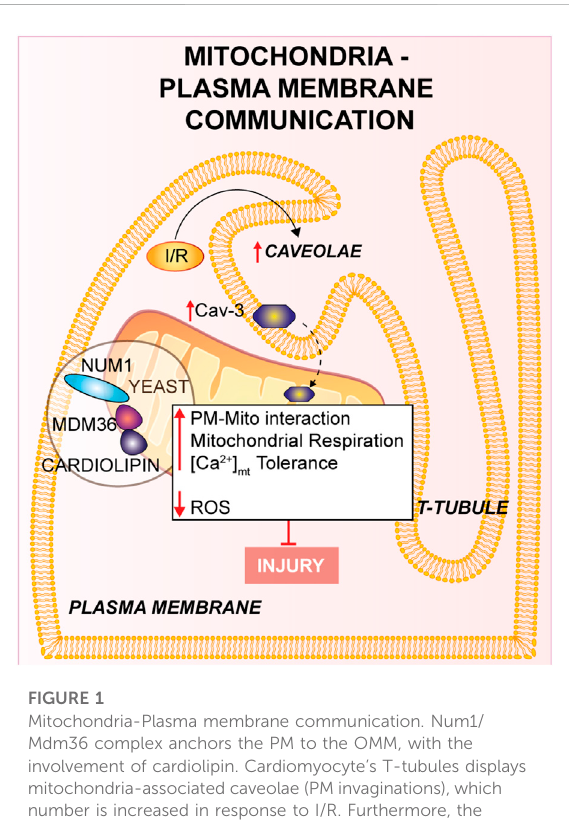
FIGURE 1 Mitochondria-Plasma membrane communication. Num1/ Mdm36 complex anchors the PM to the OMM, with the involvement of cardiolipin. Cardiomyocyte ’ s T-tubules displays mitochondria-associated caveolae (PM invaginations), which number is increased in response to I/R. Furthermore, the overexpression of Cav-3 showed a cardioprotective effect against I/R.